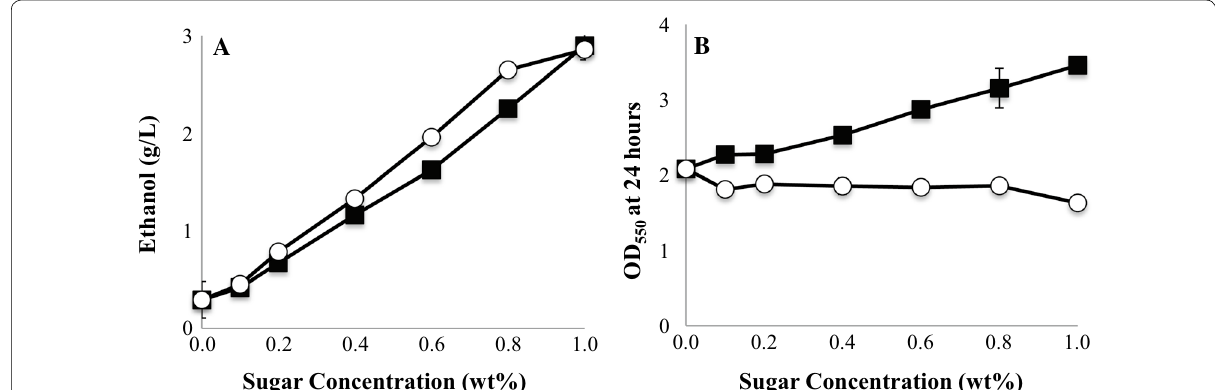
Fig. 2 Mechanocatalytic sugars (filled squares) support ethanol production with titers similar to those observed for pure glucose (white circles). Fermentation was performed with ethanologenic E. coli KO11 lgk in LB for 24 h at 37 °C, 200 rpm. a Ethanol production; b growth. Data is the + average of three biological replicates, with error bars indicating one standard